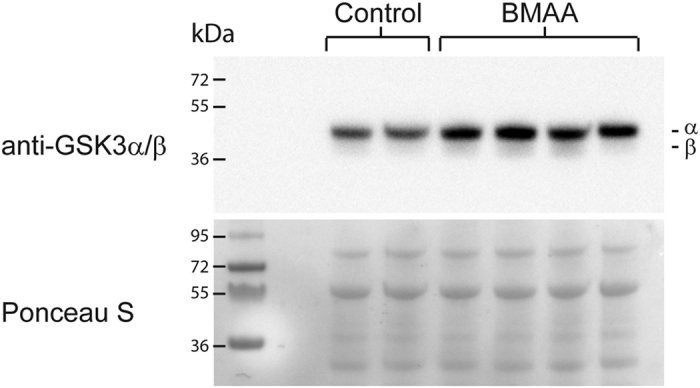
Embryonal BMAA-injection increases GSK3α/β expression in larvae.Embryos injected with 6.5 ng BMAA or solvent control at one-cell stage were harvested 4 dpf. Proteins were extracted from whole larvae (n > 50) and subjected to Western blotting using anti-GSK-3α/β. Ponceau-S staining was used as loading control. Blot shows control and BMAA-injected samples from two individual experiments.